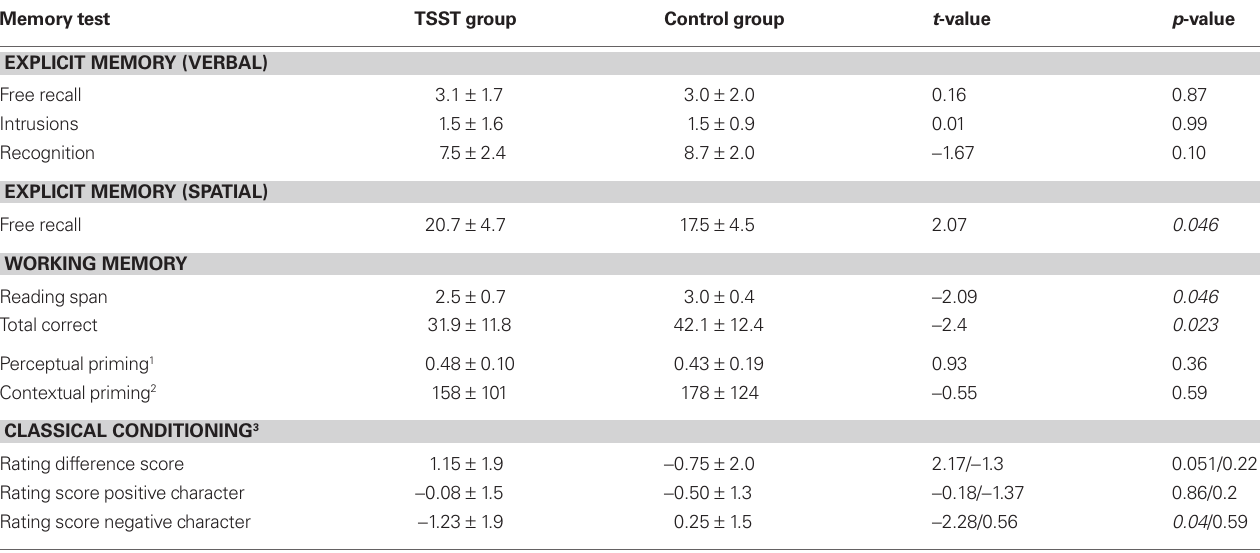
Table 2 | Descriptive statistics indicating means and standard deviations ( M ± SD ) of memory test results in the experimental and the control group. Signifi cant differences are indicated in italics ( p <